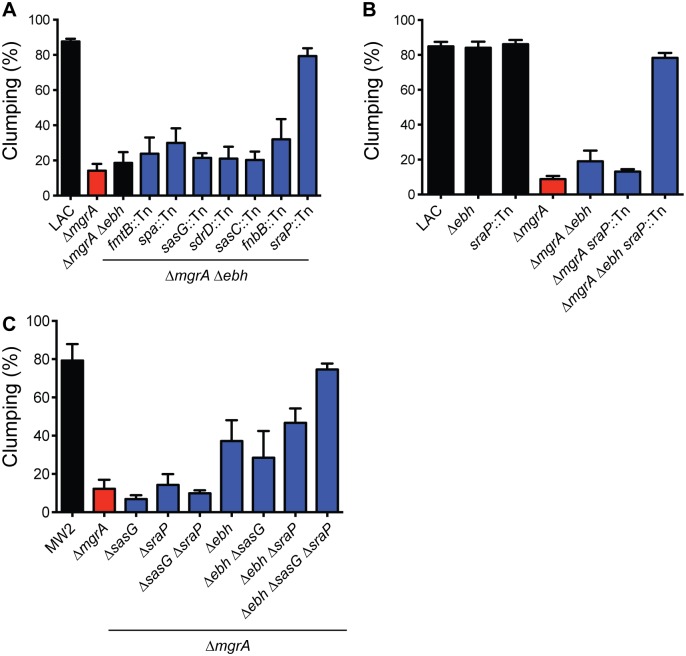
Identification of other surface proteins involved in inhibiting clumping.(A) Genes encoding surface proteins predicted to be regulated by MgrA were inactivated in an mgrA ebh double mutant background, and clumping was measured after 2 h of incubation with human plasma. (B) Comparison of clumping in LAC strains lacking combinations of mgrA, ebh, and sraP, measured after incubation with human plasma for two hours. (C) Clumping of MW2 strains lacking combinations of mgrA, ebh, sraP, and sasG. Graph shows clumping after 1 h of incubation with human plasma. All clumping results represent averages of three separate experiments.